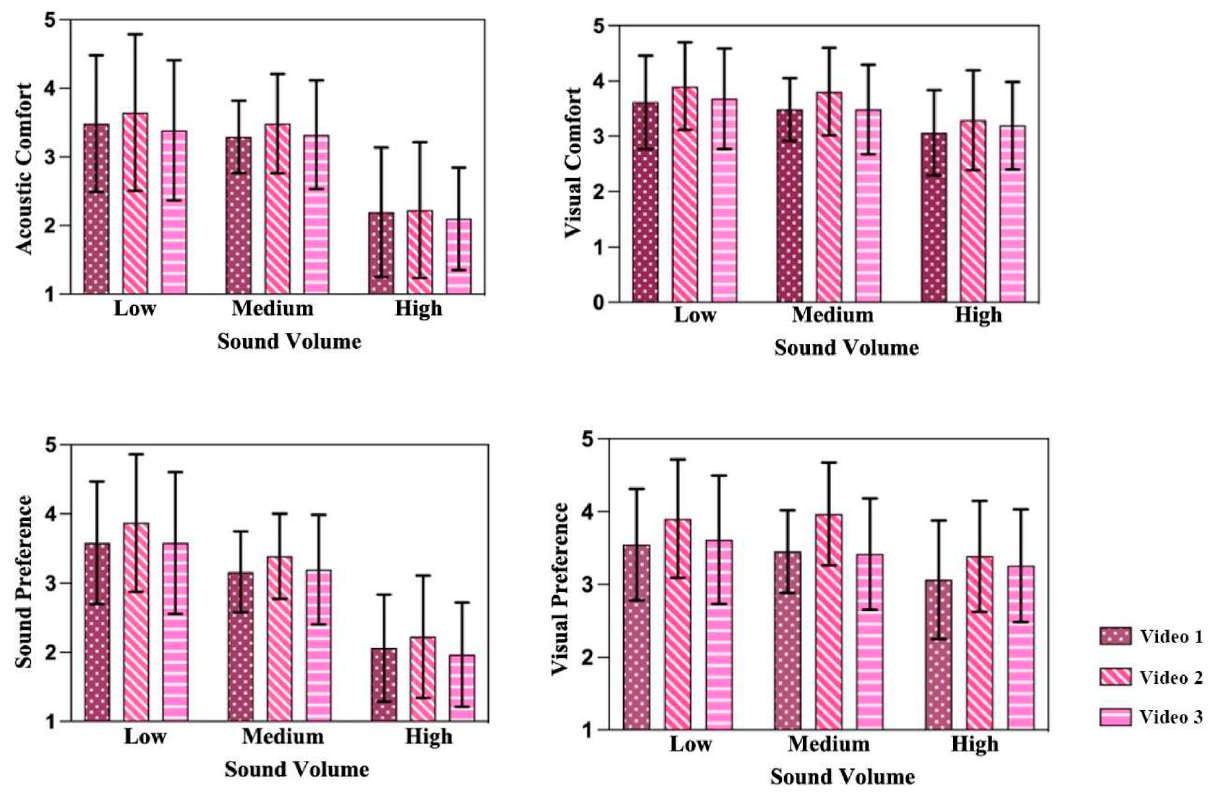
Figure 6. Mean ratings of evaluation indicators under the effect of different environments.